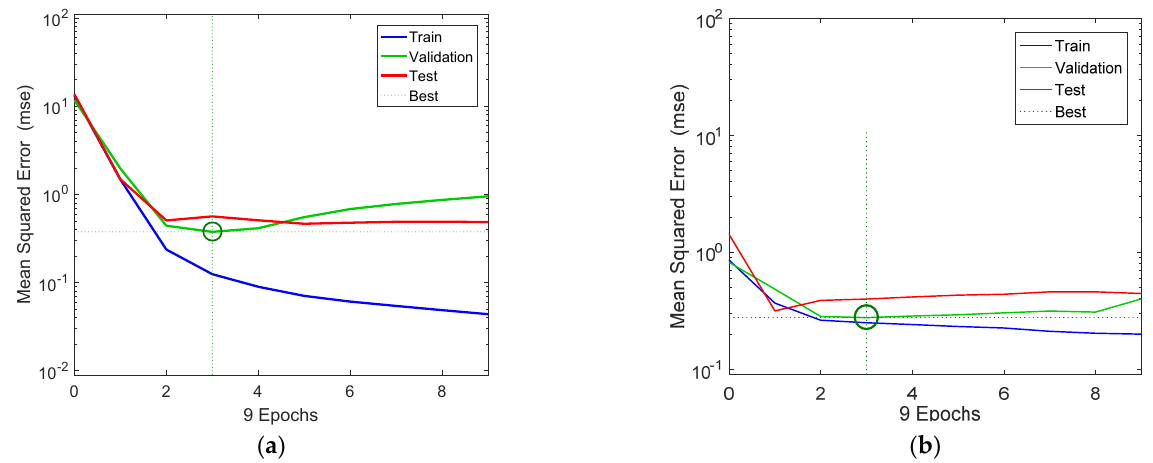
Figure 3. NARX ( a ) and FTD ( b ) neural network training, validation, and testing performance. Note that the best validation performance for the NARX model was 0.388 at epoch 3, and for the FDR model, it was 0.276 at epoch 3.